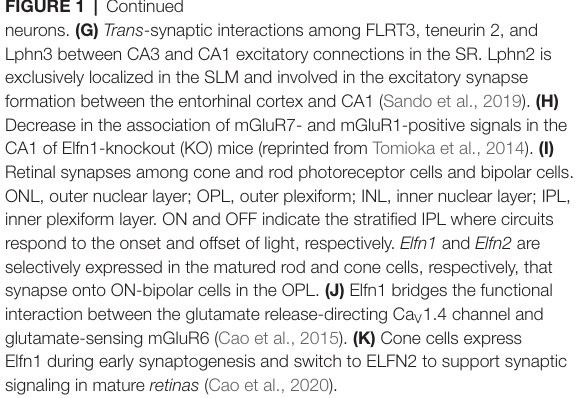
FIGURE 1 | Continued neurons. (G) Trans -synaptic interactions among FLRT3, teneurin 2, and Lphn3 between CA3 and CA1 excitatory connections in the SR. Lphn2 is exclusively localized in the SLM and involved in the excitatory synapse formation between the entorhinal cortex and CA1 (Sando et al., 2019). (H) Decrease in the association of mGluR7- and mGluR1-positive signals in the CA1 of Elfn1-knockout (KO) mice (reprinted from Tomioka et al., 2014). (I) Retinal synapses among cone and rod photoreceptor cells and bipolar cells. ONL, outer nuclear layer; OPL, outer plexiform; INL, inner nuclear layer; IPL, inner plexiform layer. ON and OFF indicate the stratified IPL where circuits respond to the onset and offset of light, respectively. Elfn1 and Elfn2 are selectively expressed in the matured rod and cone cells, respectively, that synapse onto ON-bipolar cells in the OPL. (J) Elfn1 bridges the functional interaction between the glutamate release-directing Ca V 1.4 channel and glutamate-sensing mGluR6 (Cao et al., 2015). (K) Cone cells express Elfn1 during early synaptogenesis and switch to ELFN2 to support synaptic signaling in mature retinas (Cao et al.,